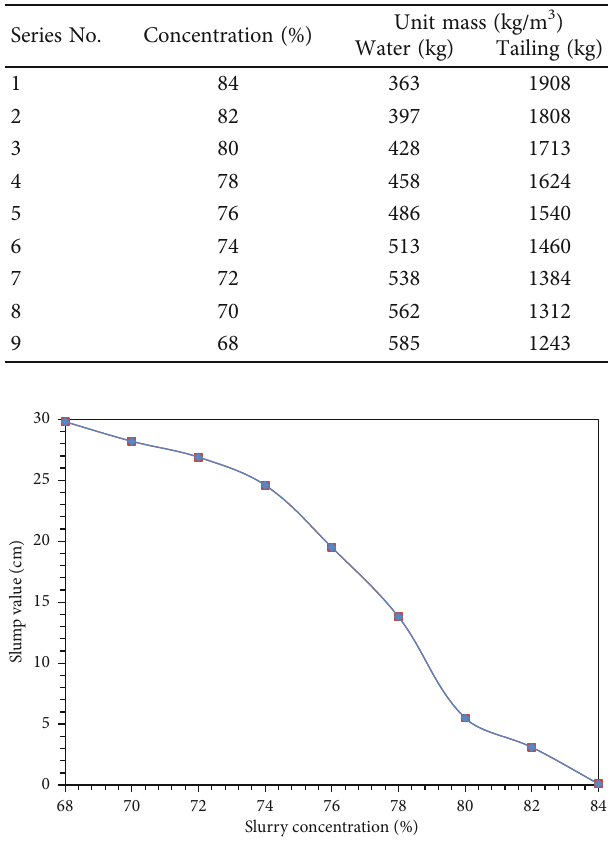
Figure 3: Slump values of tailing